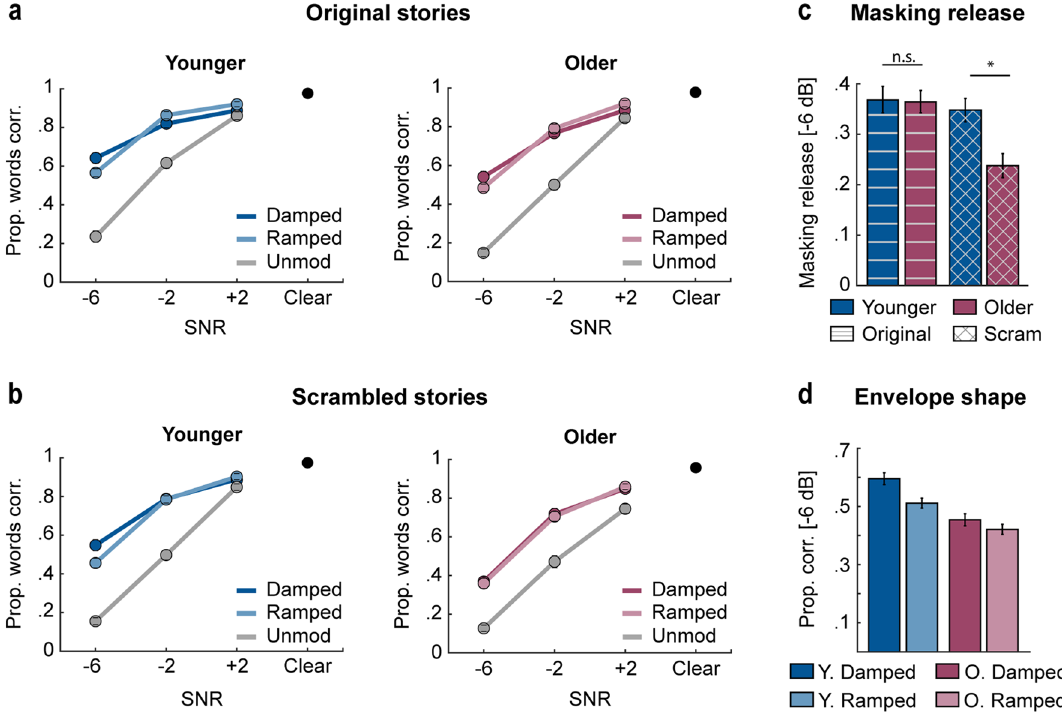
Figure 6. Intelligibility results for Experiment 3. ( a ) Mean proportion of correctly reported words for original stories is plotted as a function of SNR (– 6, − 2, + 2 dB, Clear [black dot]) for the different envelope conditions (damped, ramped, unmodulated) and for younger (left) and older adults (right). ( b ) Mean performance for scrambled stories is plotted as a function of SNR (− 6, − 2, + 2 dB, Clear [black dot]) for the different envelope conditions (damped, ramped, unmodulated) and for younger (left) and older adults (right). ( c ) Mean difference in intelligibility between modulated and unmodulated maskers (masking release) at − 6 dB SNR is plotted for each story type (original, scrambled) and age group (younger, older). ( d ) Mean performance at − 6 dB SNR is plotted for the different masker envelope shapes (damped, ramped) and age groups. Error bars reflect the standard error of the mean. *p <